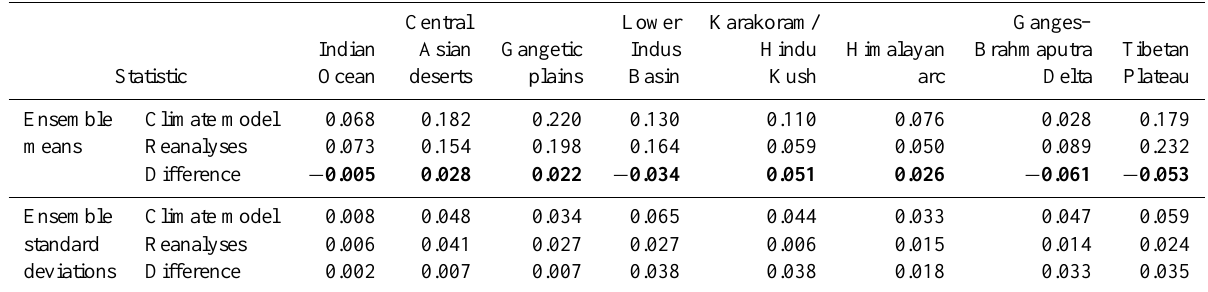
Table 6. Comparison of RQUMP perturbed physics ensemble climate model subregional climate zone distributions to those from the reanal- ysis